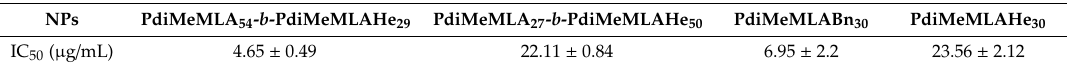
Table 7. Values of IC 50 of the homopolymer- and amphiphilic block copolymer-based NPs in HepaRG